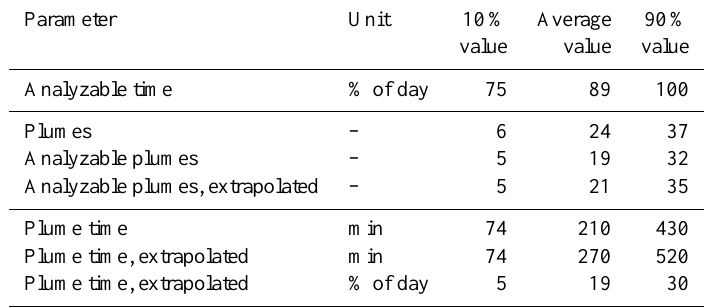
Table 3. Daily values of the plume parameters. Some of the values are extrapolated to also cover the unanalyzable time periods of the day. Parameter